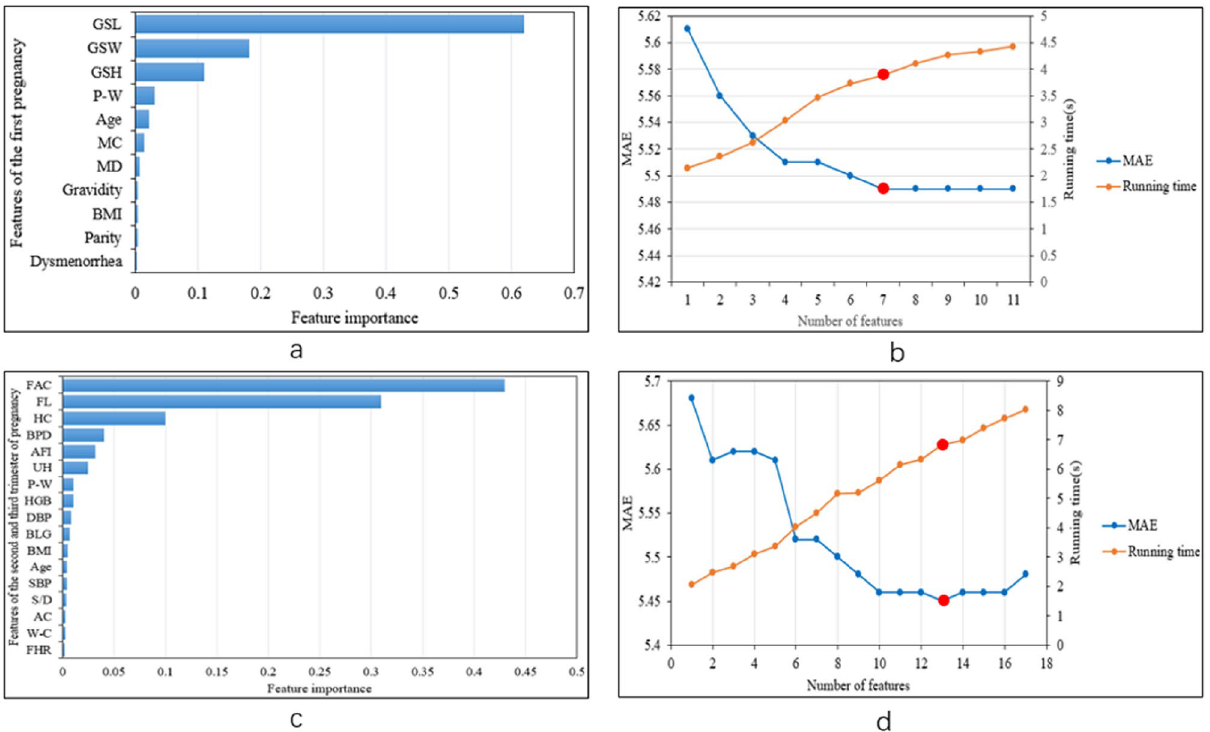
Figure 4. Analysis result for feature selection of different datasets. a shows the feature importance of the first pregnancy. b shows the MAE and running time with different number of features. c represents the feature importance of the second and third trimester of pregnancy. d represents the MAE and running time with different number of features in the second and third trimesters of pregnancy